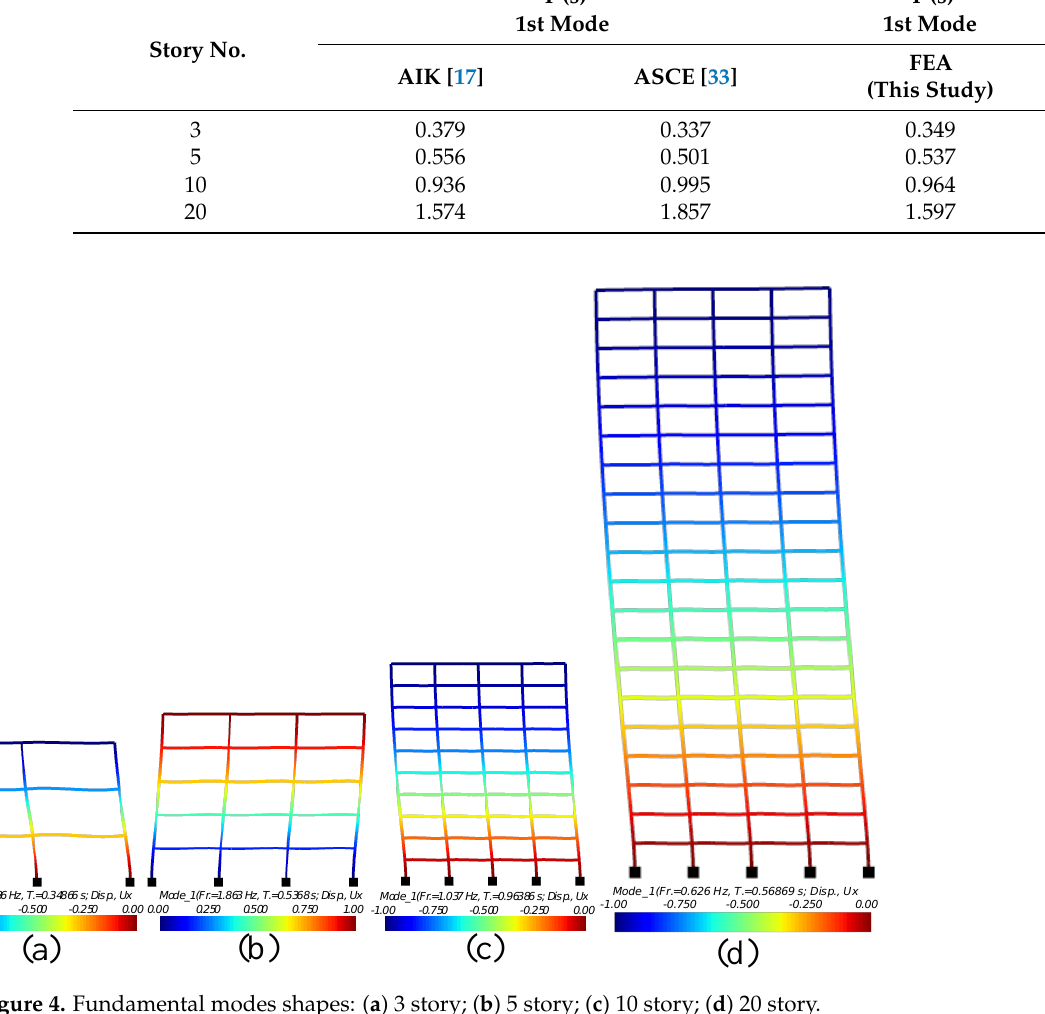
Figure 4. Fundamental modes shapes: ( a ) 3 story; ( b ) 5 story; ( c ) 10 story; ( d ) 20 story.